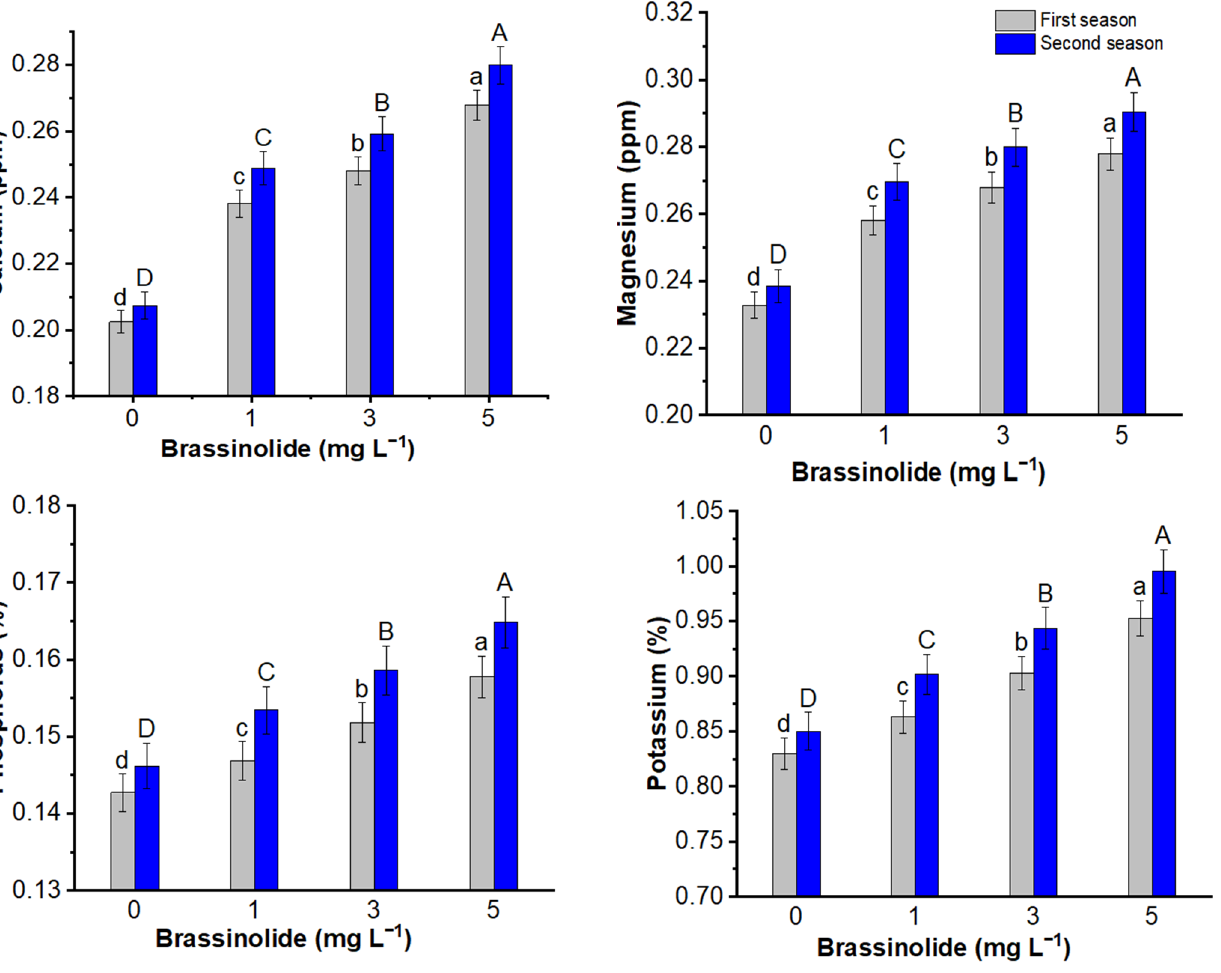
Figure 7. Ca (ppm), Mg (ppm), P (%), and K (%) of Opuntia ficus-indica L., as affected by brassinolide foliar spray. Data are mean value ± SE. Bars with the same letters (lowercase for the first season and uppercase for the second season) are not significant at p ≤ 0.05 level.